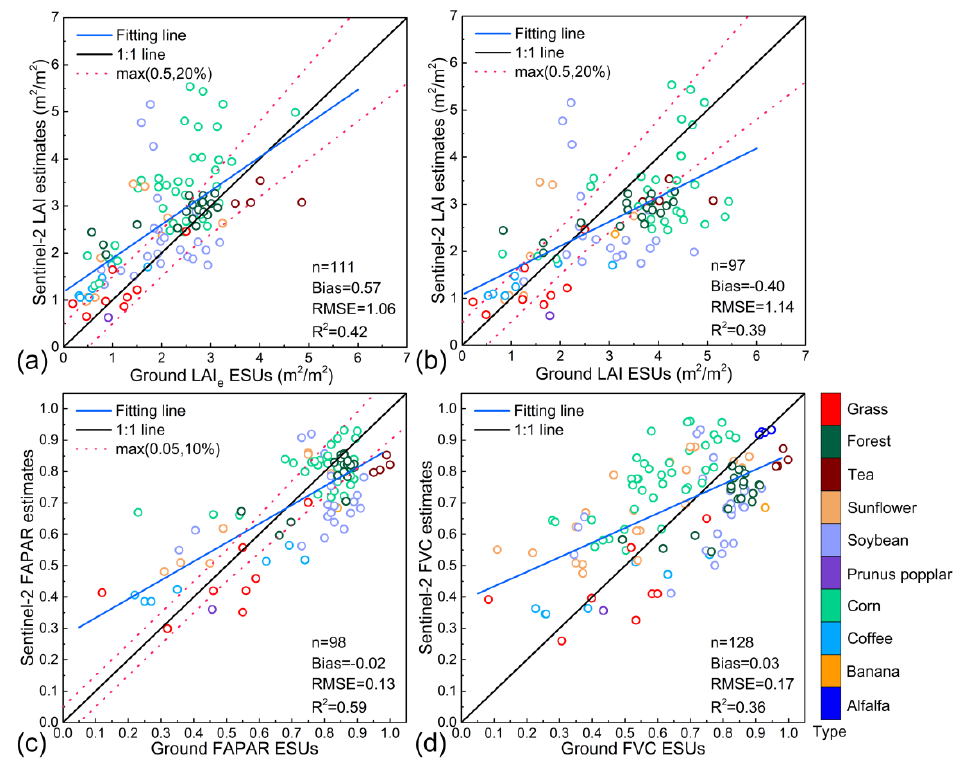
Figure 8. The comparisons between ground ESUs and Sentinel-2 biophysical estimates. ( a ) Ground LAI e ESUs versus Sentinel-2 LAI estimates; ( b ) Ground LAI ESUs versus Sentinel-2 LAI estimates; ( c ) Ground FAPAR ESUs versus Sentinel-2 FAPAR estimates; ( d ) Ground FVC ESUs versus Sentinel-2 FVC estimates. The colors stand for different vegetation types (i.e., crop types, forests, and grasses, respectively) shown in the right colorbar. The blue and black solid lines denote the fitting line and 1:1 line, respectively. The red dashed lines show the Global Climate Observing System (GCOS) specifications boundaries for LAI e (max (0.5, 20%), LAI (max (0.5, 20%)) and FAPAR (max (0.05,